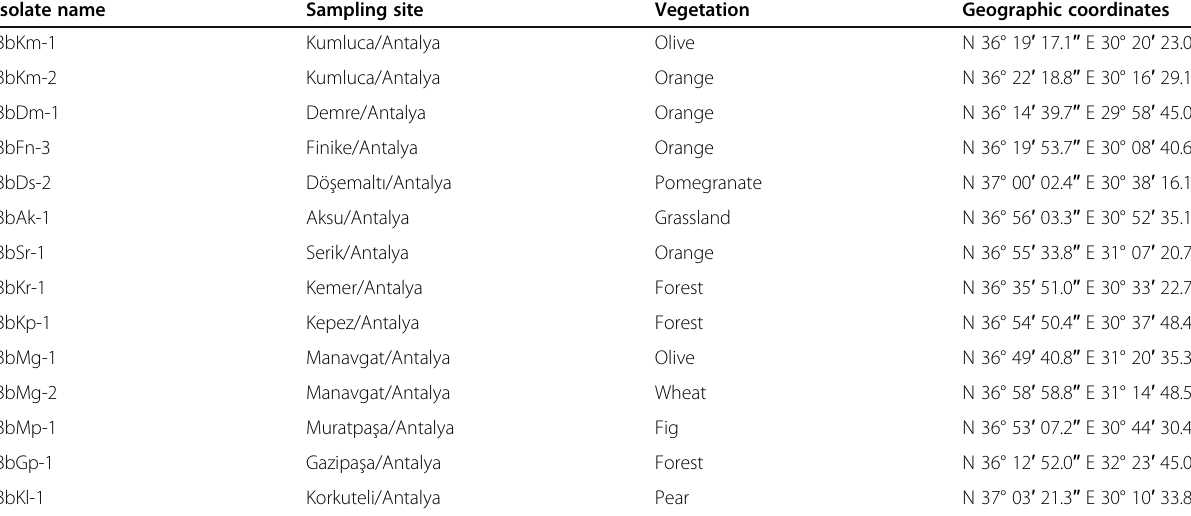
Table 1 Indigenous isolates of Beauveria bassiana used in the experiments Isolate